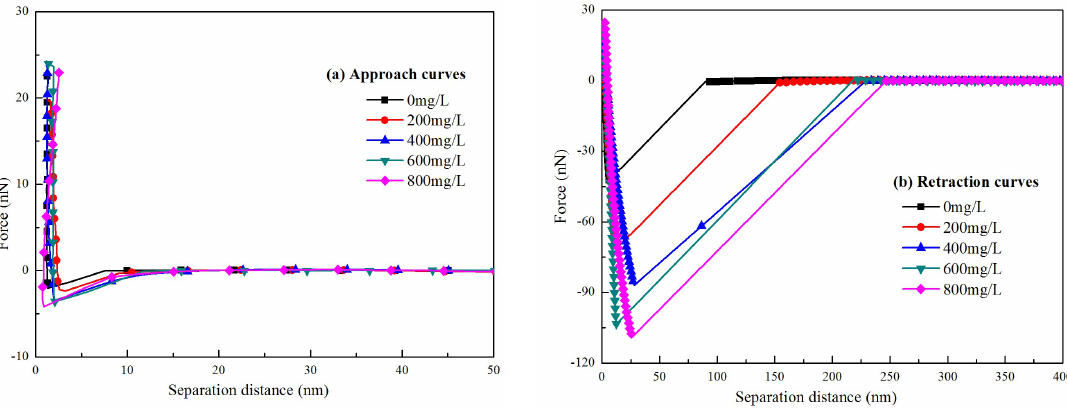
Figure 9. Interaction force between molybdenite surface and kaolinite particle in gypsum solution. ( a ) Approach curves; ( b ) Retraction curves.